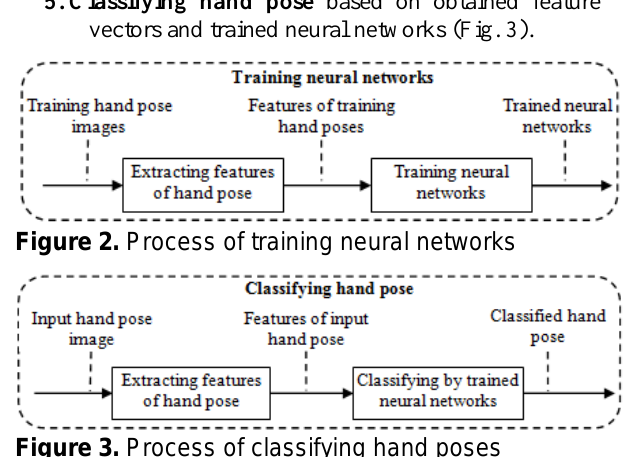
Figure 3. Process of classifying hand